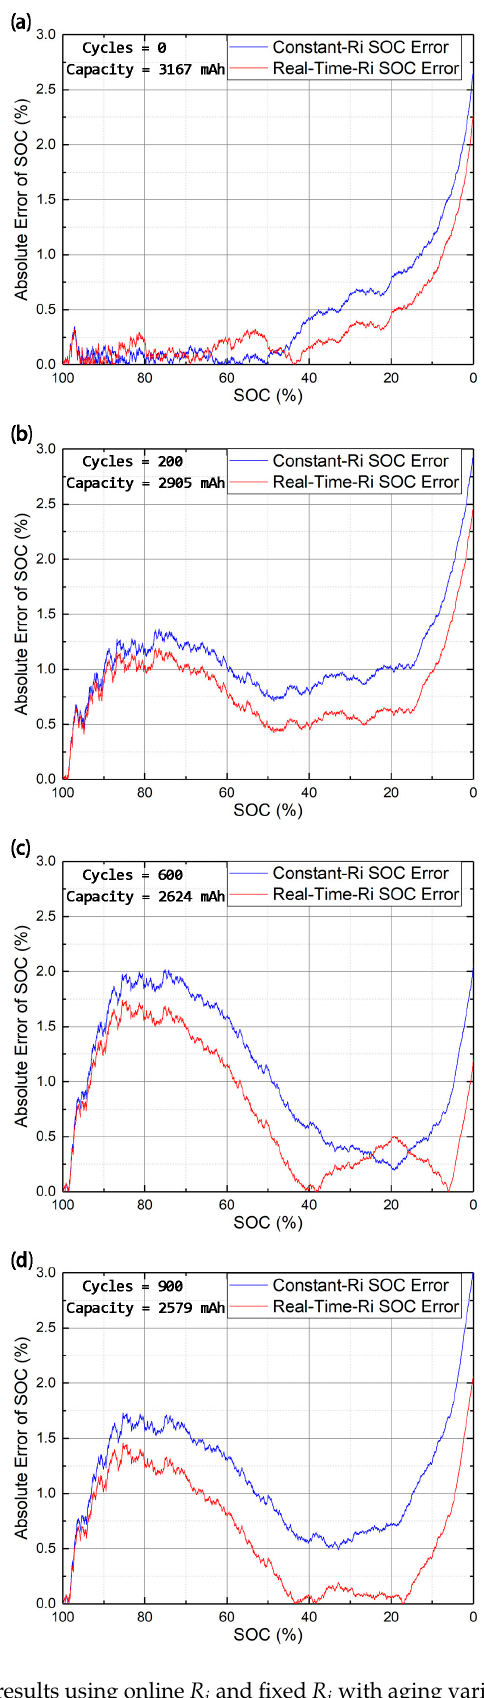
Figure 8. SOC estimation results using online R i and fixed R i with aging variations. ( a ) the battery with 0 cycles; ( b ) the battery with 200 cycles; ( c ) the battery with 600 cycles; ( d ) the battery with 900 cycles.